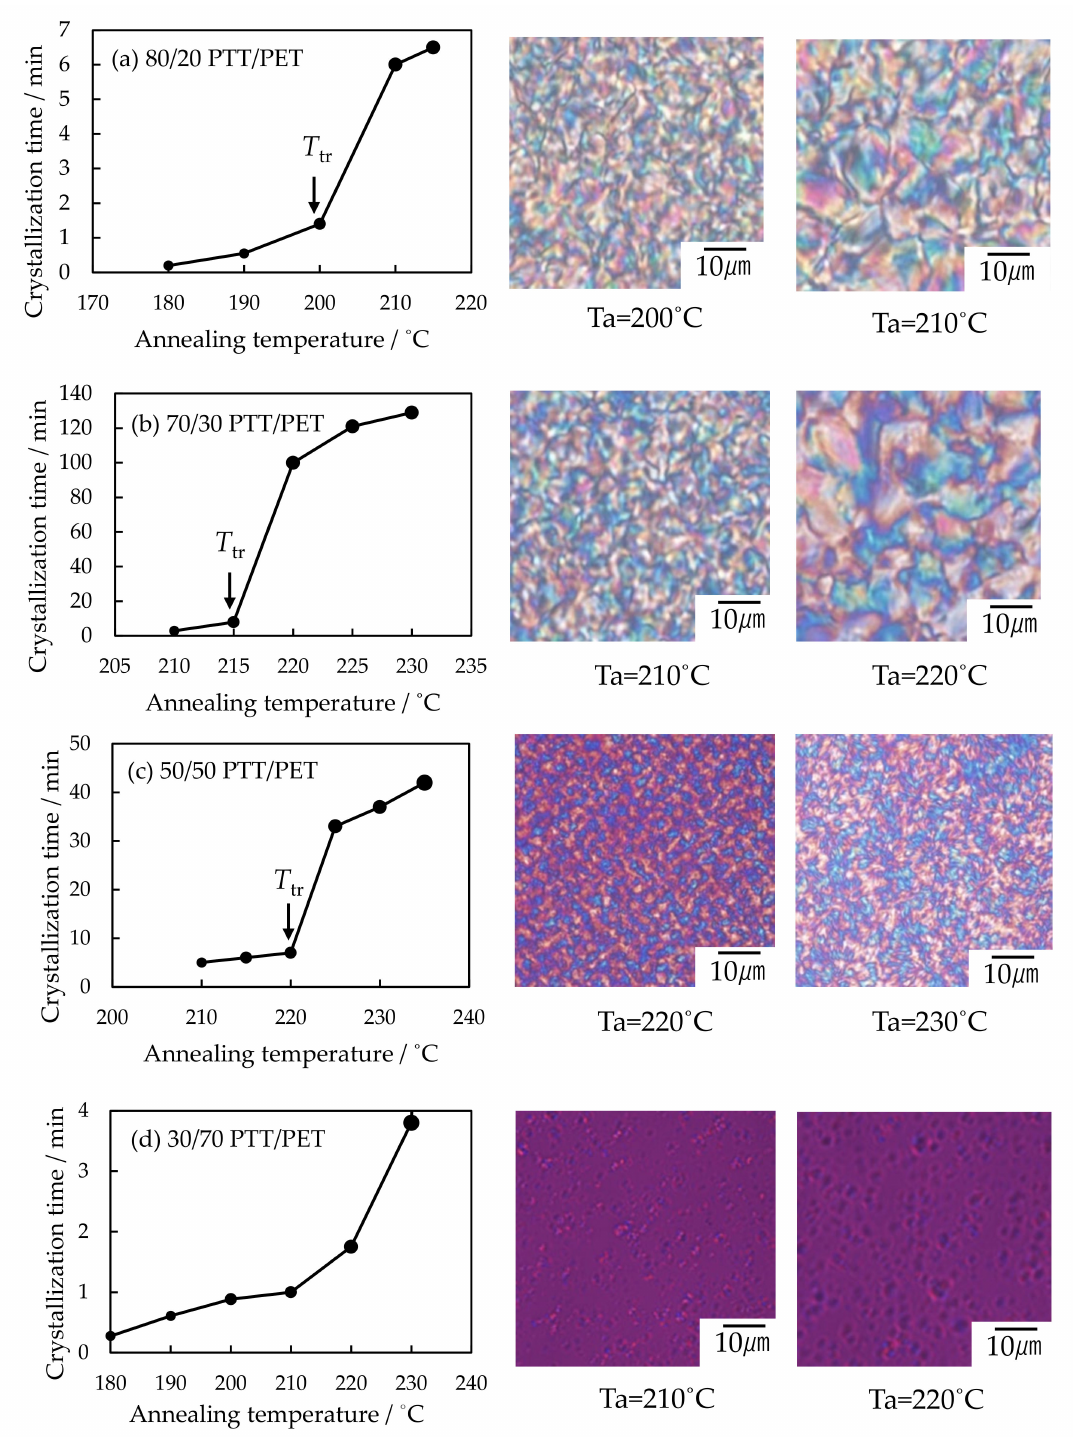
Figure 12. Crystallization rate at various crystallization temperatures and the crystalline morphology at around the T tr of PTT / PET blends at various blend compositions: ( a ) 80 / 20, ( b ) 70 / 30, ( c ) 50 / 50 and ( d ) 30 / 70 PTT /